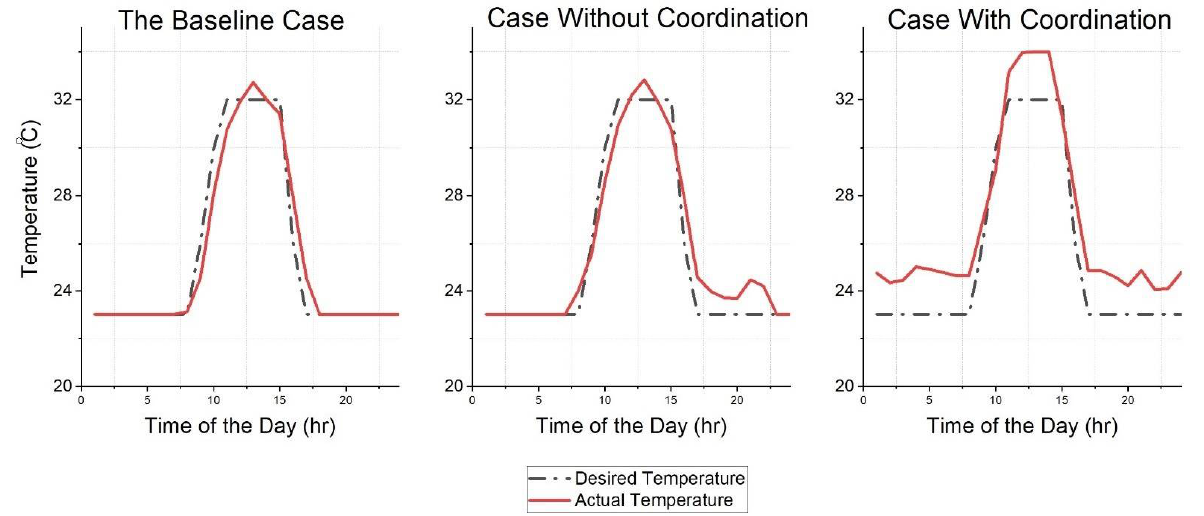
Figure 8. The comparison of the mean indoor temperature for a residential building. Figure 9 describes how the model changes the aggregate load profile’s shape by shifting controllable assets to off-peak hours. The green graph shows that the baseline case’s peak loads were in peak hours, undeniably increasing the energy costs. The red chart belongs to the case that buildings were trying to optimize their objectives separately.